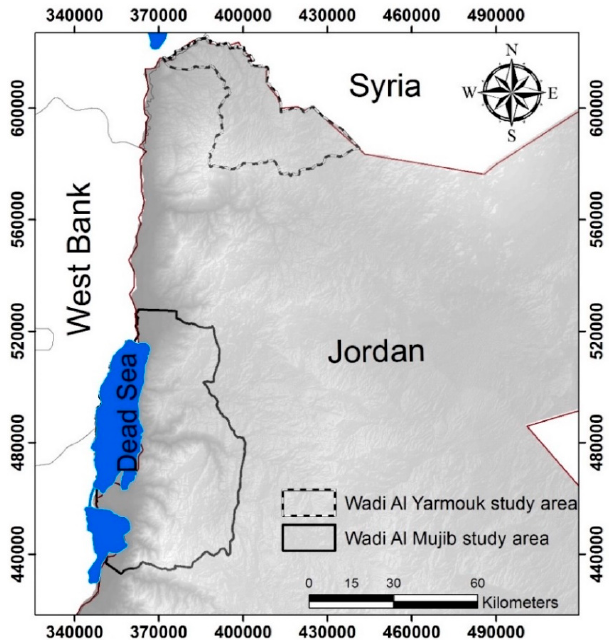
Figure 1. Location of the studied areas. The Wadi Yarmouk study area in the north-west of Jordan which has historical sites, a large area of agricultural activities, and an urbanized area. The Wadi Mujib study area in the Middle West of Jordan which has tourism investments and a beach at the Dead Sea. The names of Yarmouk and Mujib are written with letters (Al) in some references.